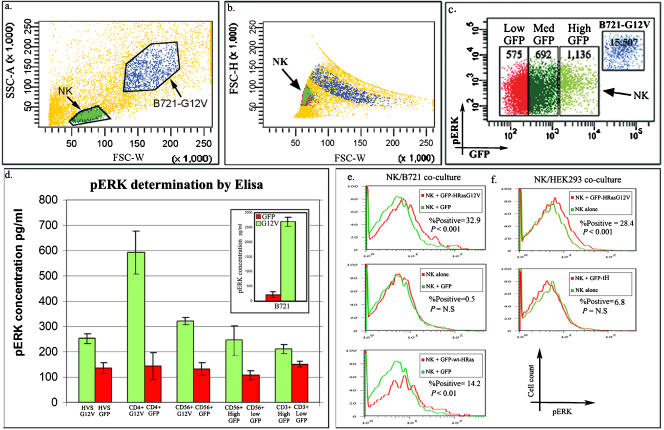
The acquisition of oncogenic H-RAS at the IS results in ERK phosphorylation within the acquiring lymphocytes.(a–c) NK cells were co-cultured with B721−GFP-H-RasG12V for 2 hours. The collected cells were fixed/permeabilized, stained for intracellular pERK and analyzed by FACS. Dot plots a+b depict the careful gating strategy used to distinguish singlet NK cells (green) from duplets and B721 cells (blue), and dot plot c shows GFP-H-RasG12V vs. pERK levels. The NK population was divided into three subpopulations (red, dark green and bright green) according to their GFP content. Bold numbers indicate the MFI of pERK. Shown is a representative experiment out of the five performed (data from ∼20,000 events). (d) T and NK lymphocytes from various co-cultures of B721-GFP-H-RasG12V (G12V) or B721-GFP (GFP) were either isolated using the MACS® cell separation system or sorted (as described in Fig. 1b) into GFP-H-RasG12Vhigh and GFP-H-RasG12Vlow cells. The cells were then lysed and pERK levels were determined by ELISA. Total pERK levels in lysates of B721-H-RasG12V relative to B721-GFP were also determined in parallel as controls for test performance (inset). Assays were performed in duplicates and bars represent the mean±SD from a typical experiment out of >5 performed. (e) NK cells were co-cultured with B721 cells stably expressing either GFP-H-RasG12V, GFP-H-Ras(wt) or GFP for 2 hours. The upper overlay histogram depicts total pERK levels within GFP-H-RasG12Vhigh NK cells compared to control NK cells. The middle overlay histogram compares total p-ERK levels in NK cells co-cultured with B721-GFP versus control NK cells. The lower overlay histogram shows p-ERK levels within GFP-H-Ras(wt)+ NK cells compared to control NK cells. (f) NK cells were co-cultured with HEK293 transfected with either GFP-H-RasG12V or GFP-tH constructs for 2 hours. The overlay histograms depict total p-ERK levels within GFPhigh NK cells in the two co-cultures (red lines) compared to control NK cells (green lines). The FlowJo V6.4.7 population comparison platform was used to calculate %Positive cells found in the sample compared to control (super enhanced D-Max algorithm), and the probability binning Chi(T) algorithm was used to determine the statistical significance of the difference between samples (P value).